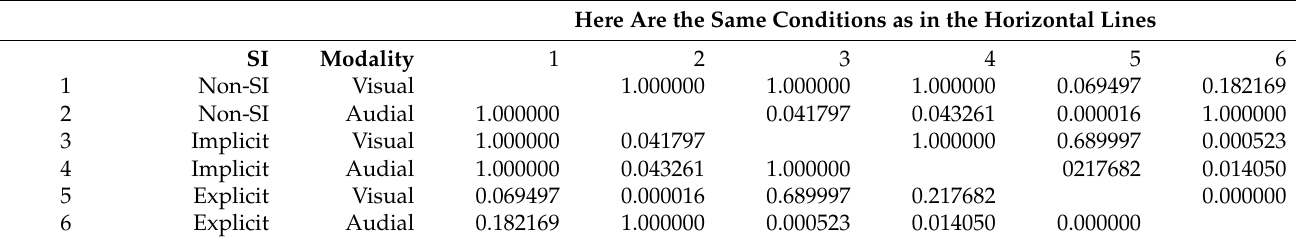
Table 3. The Post Hoc analysis with Bonferroni correction results. Here Are the Same Conditions as in the Horizontal